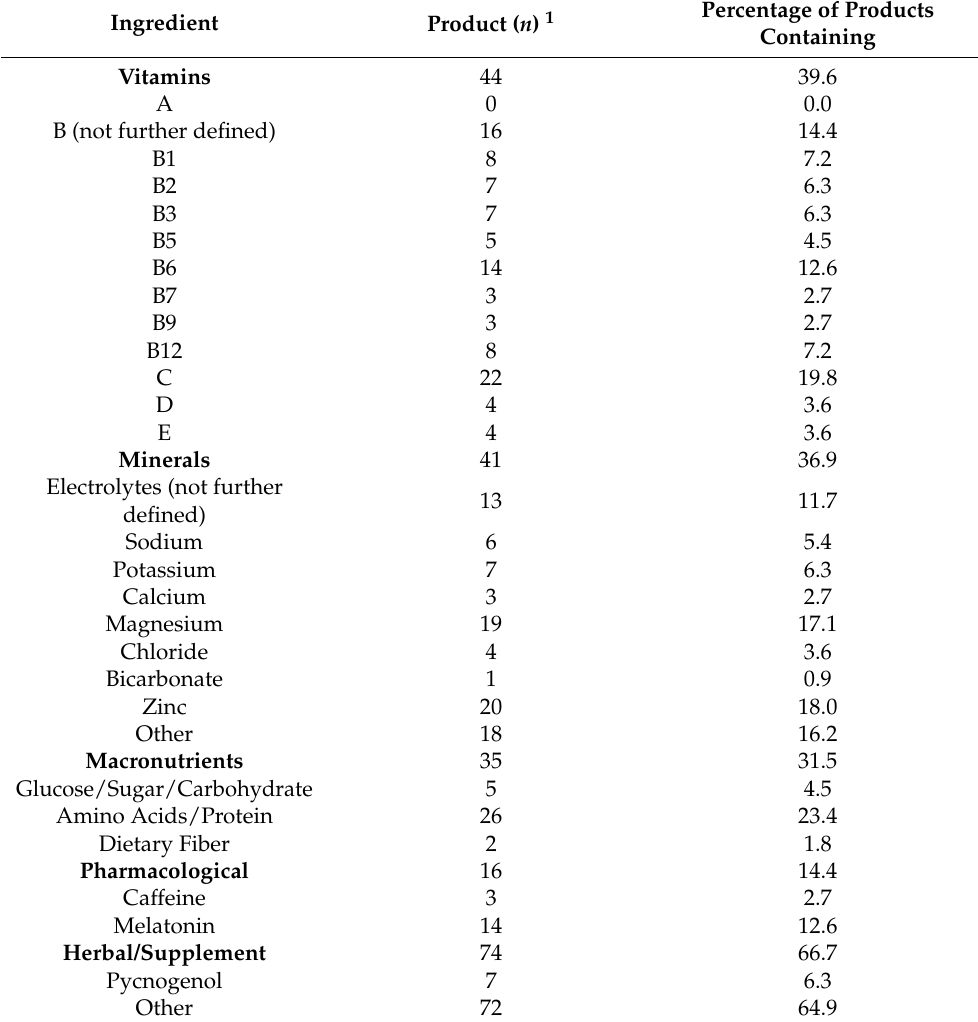
Table 2. Ingredients advertised by products ( n = 111) identified in scoping review of functional foods, beverages, and nutritional supplements that target air travel